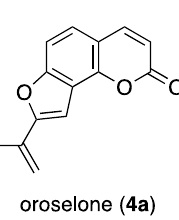
Figure 4. Structure of oroselone ( 4a )